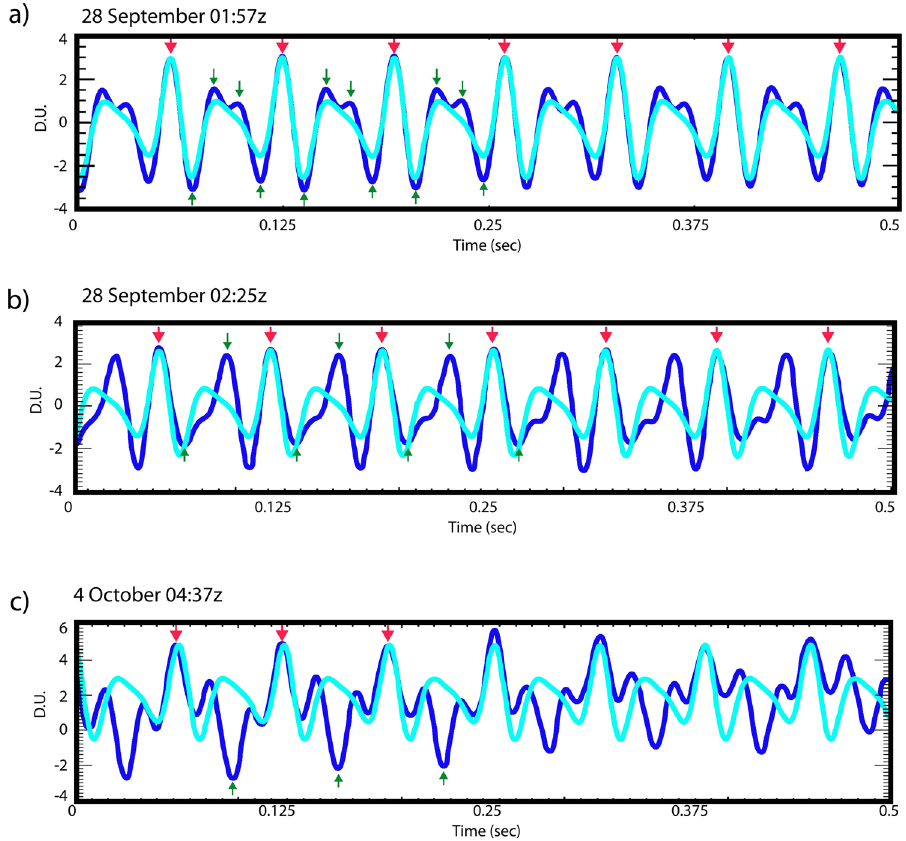
Figure 5. Three detailed records of B calls recorded by a hydrophone (dark blue) and model of B call produced using eq. 1 (light blue). Signal ( a ) is from 28 September (same signal as in Fig. 1), ( b ) is ~30 min after ( a ), and ( c ) is call recorded 6 days later. Arrows point at significant components of the actual B call signal (dark blue). Red arrows show the fundamental frequency of the B call which is the direct arrival phase (the acoustic phase with a direct path from the whale to the hydrophone). Green arrows highlight later arriving, lower amplitude signal components that include the call overtones. Time delays as well as amplitude and polarity changes are introduced into these lower amplitude signal components by propagation effects such as reflection off nearby seafloor structures (e.g. reefs, sand bars) or possibly cavities or bony structures within the whale. Signal ( a ) shows best match of model to real blue call. Signals ( b ) and ( c ) show more mismatch in signal width, amplitude and polarity of later arriving phases possibly due to changing position and orientation of the whale relative to seafloor structures. Ocean noise levels are also much higher before and after 28 September which likely contributes to mismatch of model in ( b ) and ( c